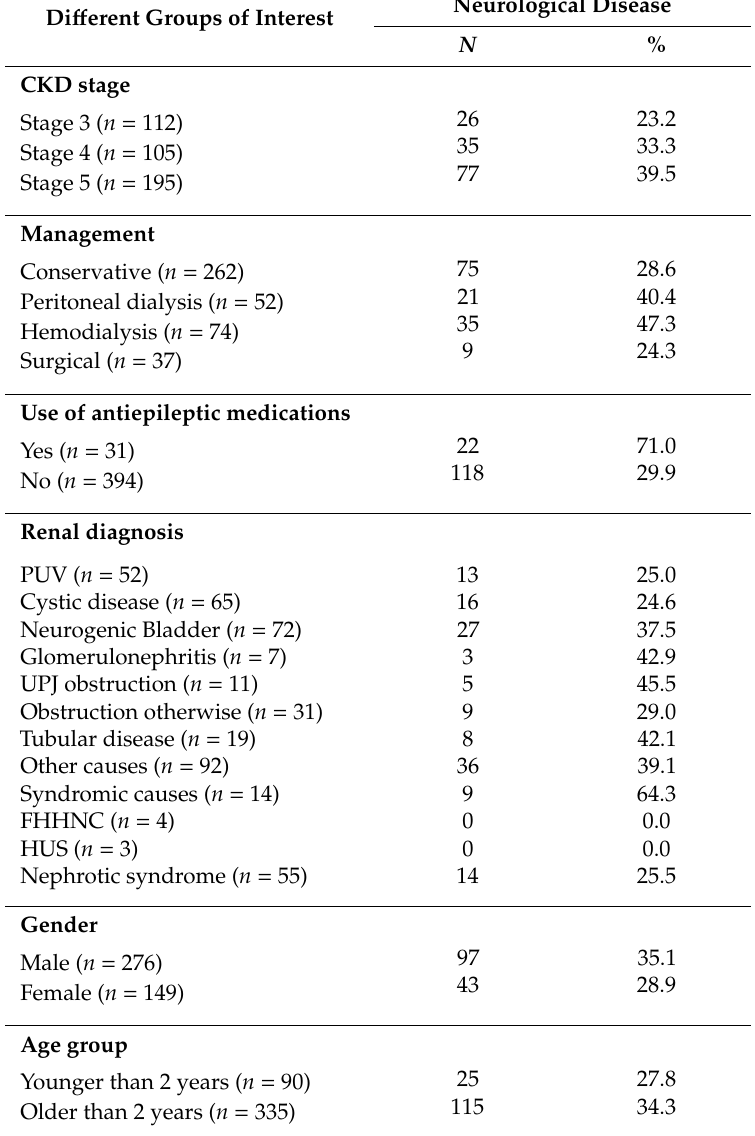
Table 3. Frequency of neurological disease in each CKD stage, management, use of antiepileptic medications, renal diagnosis gender and age